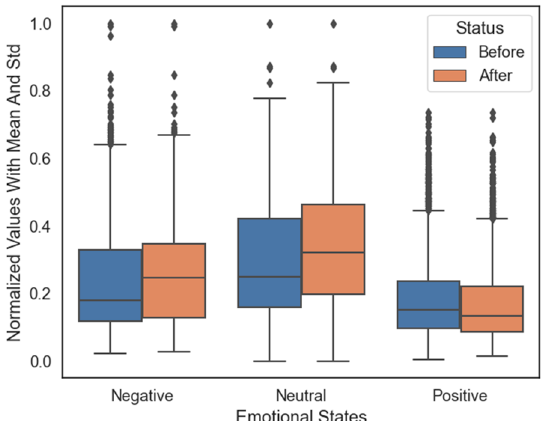
Figure 9. Normalized values with the mean and standard deviation values across the three emotional states before and after electrode selection using SAE on Subject 2. Table 2. EEG electrode selection for six entropy measures across eight subjects.